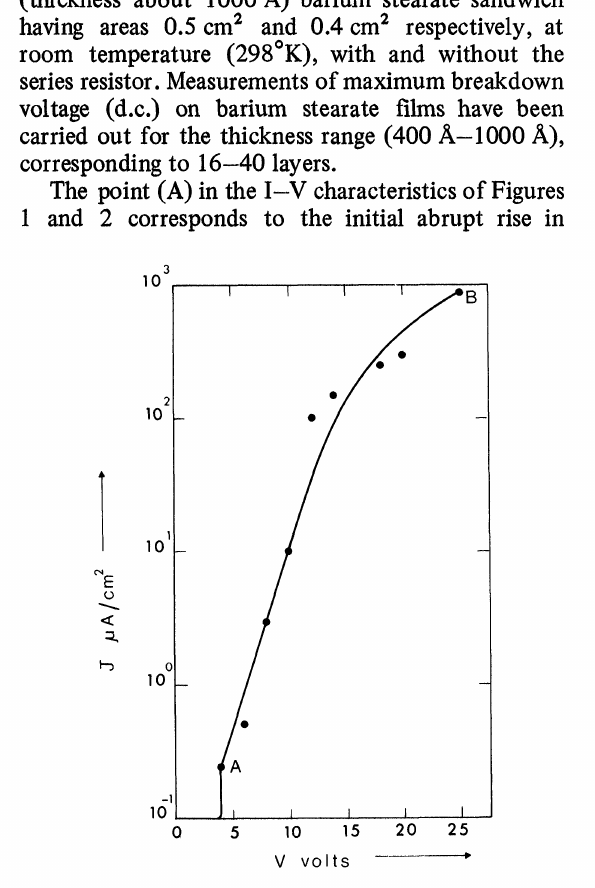
Plot of voltage (V) v/s current density (J) (with series resistor).